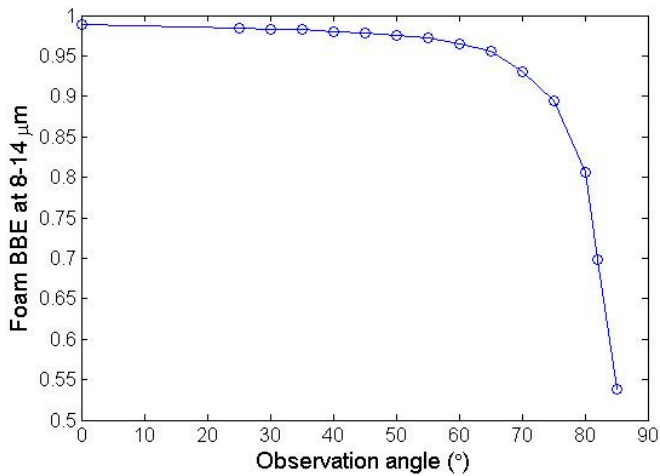
Figure 4. Scatterplot of foam broadband emissivity (BBE) with respect to the observation angle.